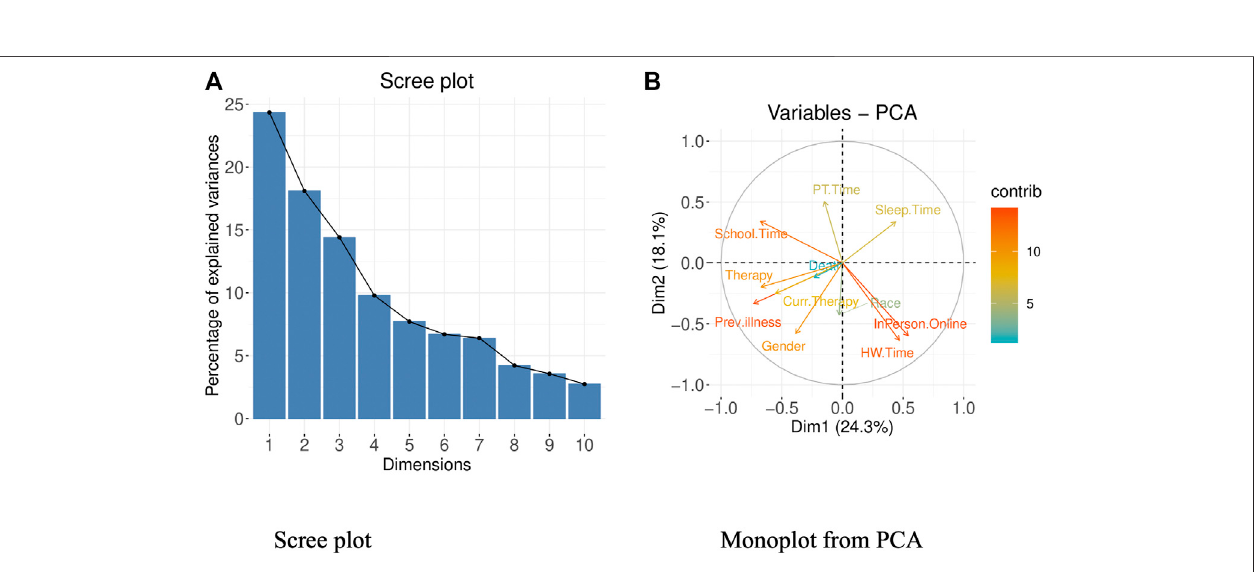
FIGURE 5 | Results from Principal Component Analysis (PCA). (A) Scree Plot from PCA. (B) Monoplot from